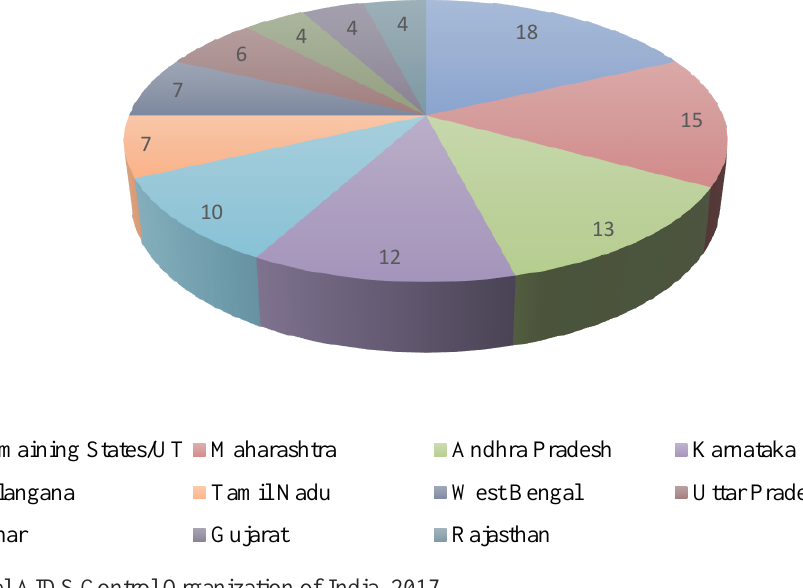
Figure 1. People Living with HIV, Percent Distribution Among States,